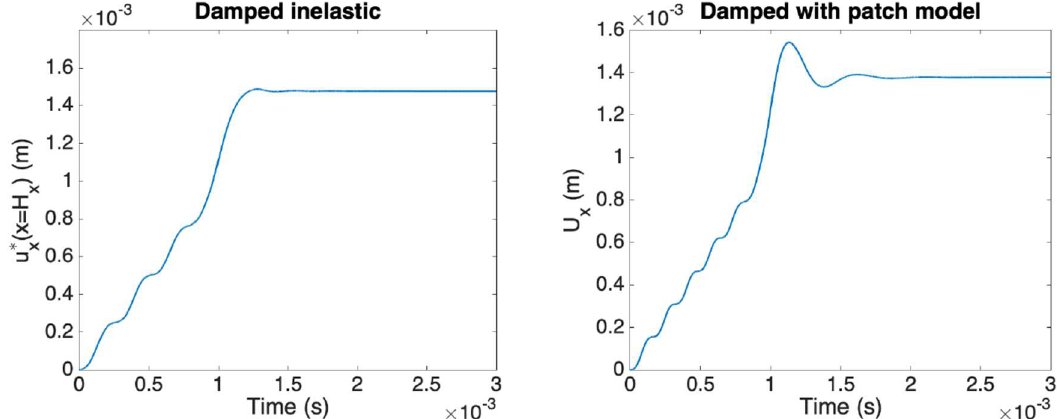
Fig. 24. Damped explicit integrations: (left) the one related to the solution in the whole domain and already depicted in Figure 20 (right); (right) the one related to the global-local integration just depicted in Figure 23 (right).